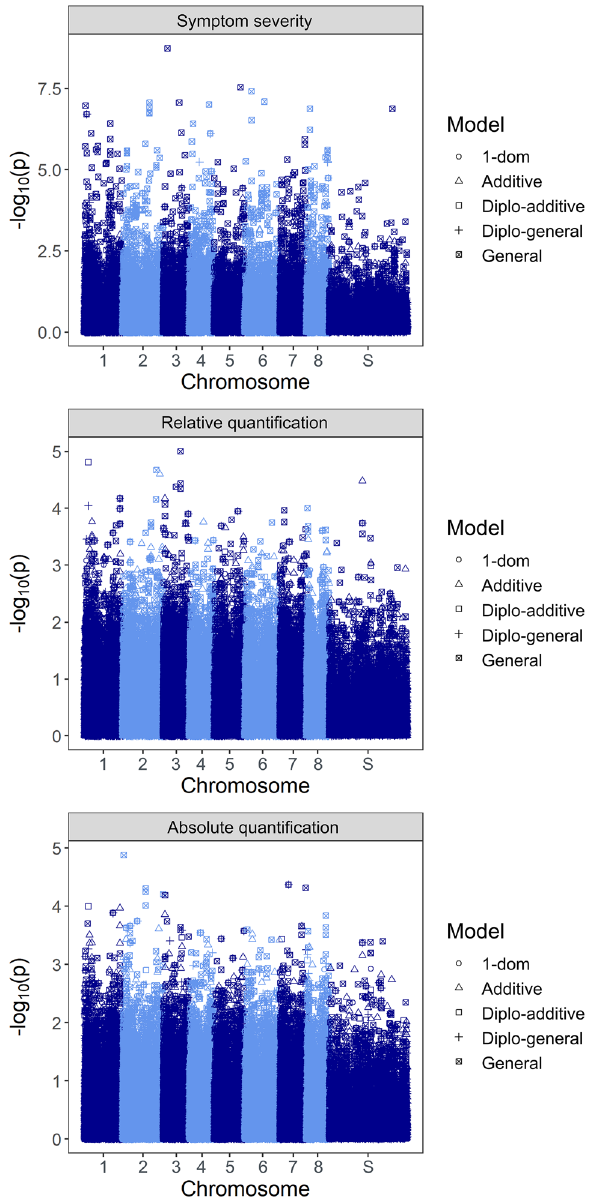
Figure 3. Manhattan plots generated in association analyses using the best linear unbiased predictor (BLUP) values of the three traits analyzed. Six different models were tested: general, additive, simplex dominant reference (1-dom-ref), simplex dominant alternative (1-dom-alt), diploidized general (diplo-general) and diploidized additive (diplo-additive). On the x-axis, S represents scaffolds not associated with any of the S. spontaneum